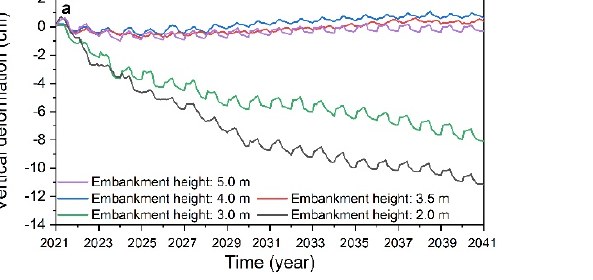
Figure 10. Vertical deformation curves at the road centerlines and the shoulders of different structures: ( a ) at the road centerline and ( b ) at the shoulder.